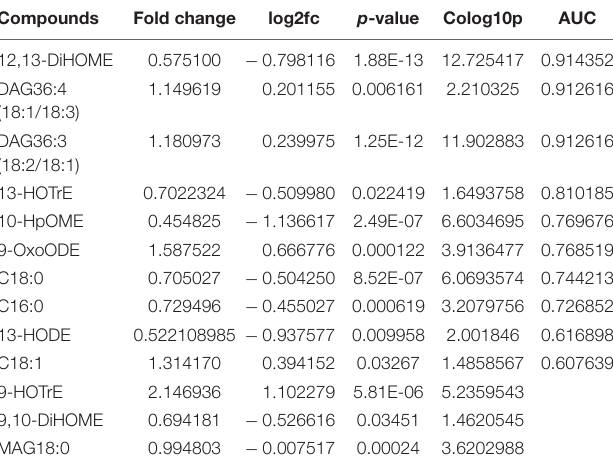
Supplementary Figure 22 and Supplementary Table 8 . RF